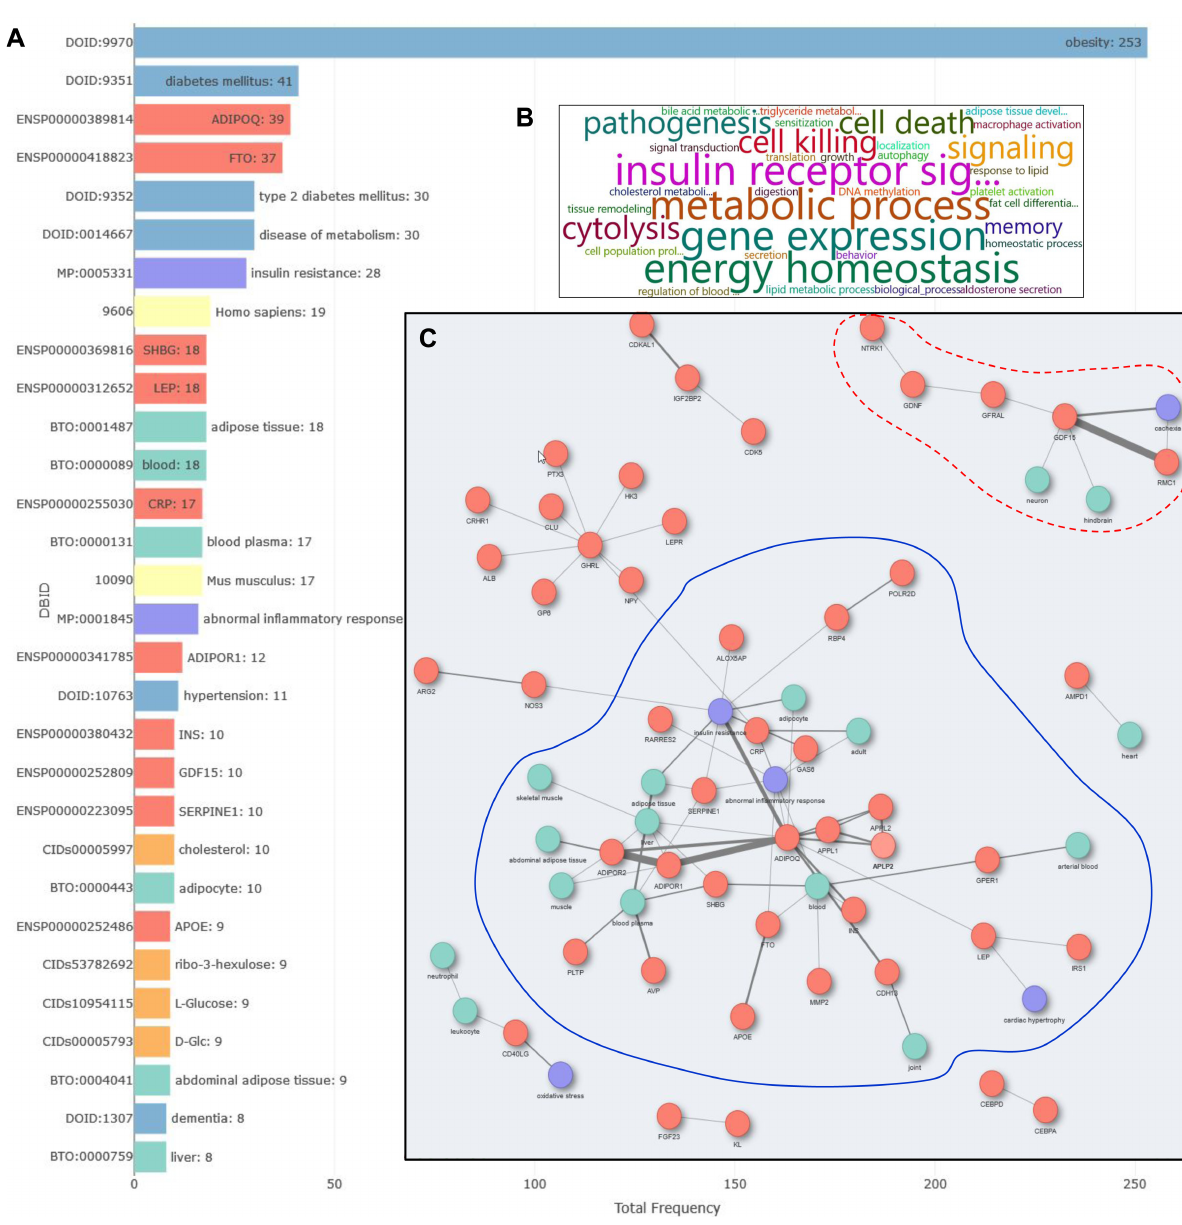
Figure 3. Assessment of Darling’s capacity for extraction of biological information and knowl- edge discovery. ( A ) Top entities (chemicals, phenotypes, proteins/genes, organisms, GO:BP, GO:CC and GO:MF, tissues, environments and diseases) plotted against frequency of occurrence in 100 DisGeNET-related publications. ( B ) GO Biological processes predicted to be mostly associated with cardiovascular disease. ( C ) Co-occurrence network depicting genes (orange circles), phenotypes (purple circles) and tissues (green circles) predicted to link cardiovascular disease and obesity. Sub- network 1, discussed in the Results section, is demarcated by the blue line and subnetwork 2 by the red